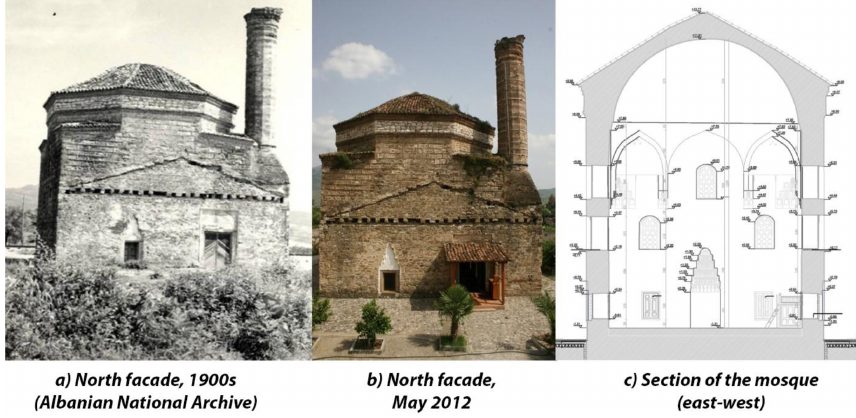
Figure 2. Main façade (a, b) and the cross section detail of the mosque (c)